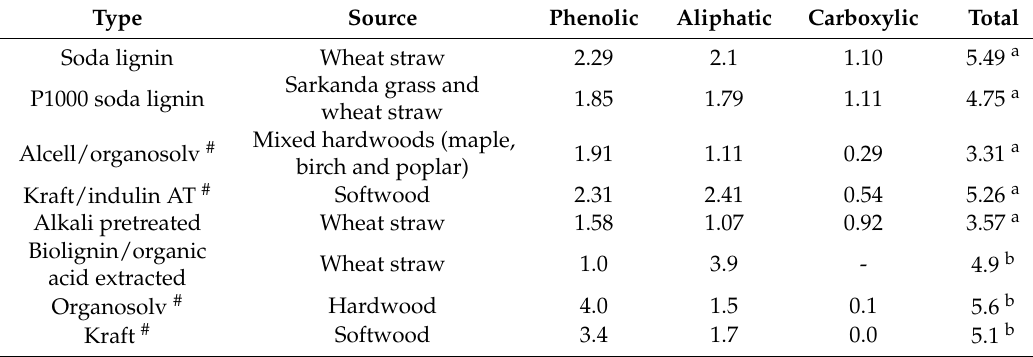
Table 1. Total hydroxyl group content of lignin (mmol · g − 1 ) based on different sources and methods of